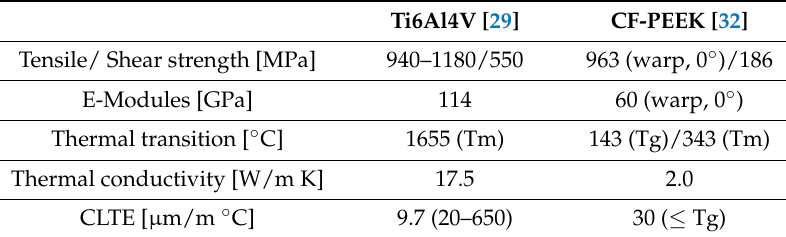
Table 2. Properties of the investigated materials.